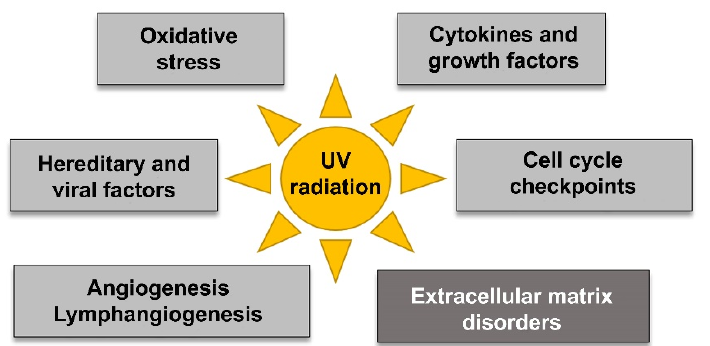
Figure 3. Summary of the multifactorial pathogenesis of pterygium.